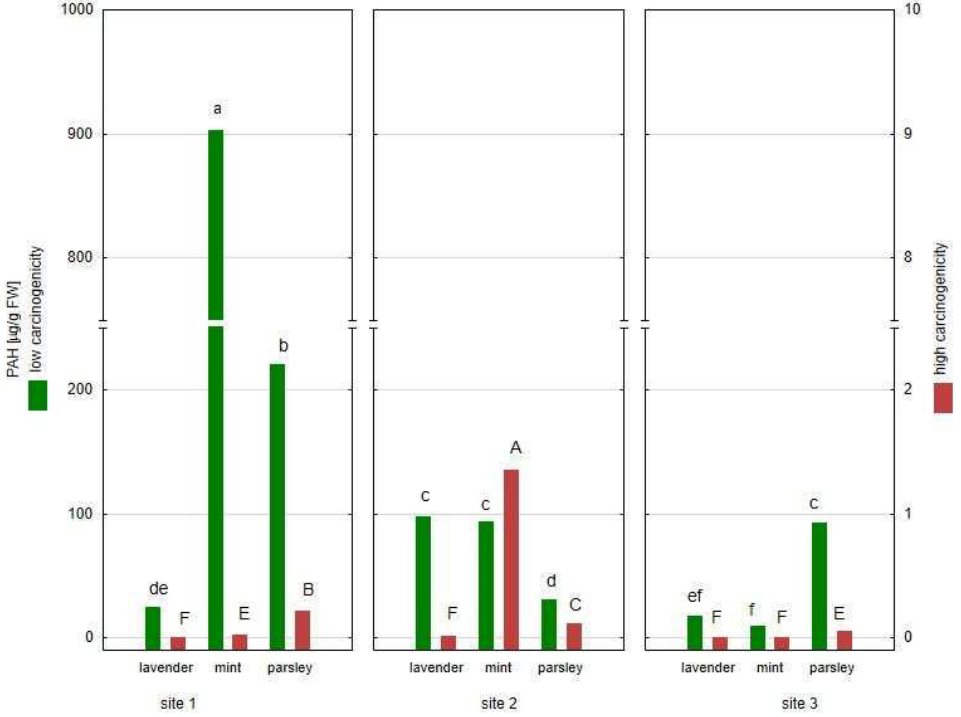
Figure 3. The content of low and high carcinogenicity PAHs in plant material expressed as average ( n = 3) (values denoted with identical letters do not differ significantly at p = 0.05 according to the post-hoc test, following two-way ANOVA for the ‘site × species’ fixed effect; FW—fresh weight).